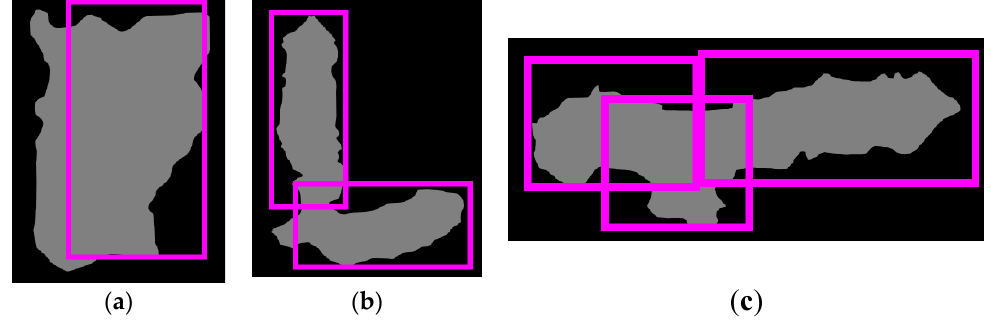
Figure 5. Three cases of YOLO results within the region of interest (RoI): ( a ) single BB; ( b ) two BBs; ( c ) three BBs.